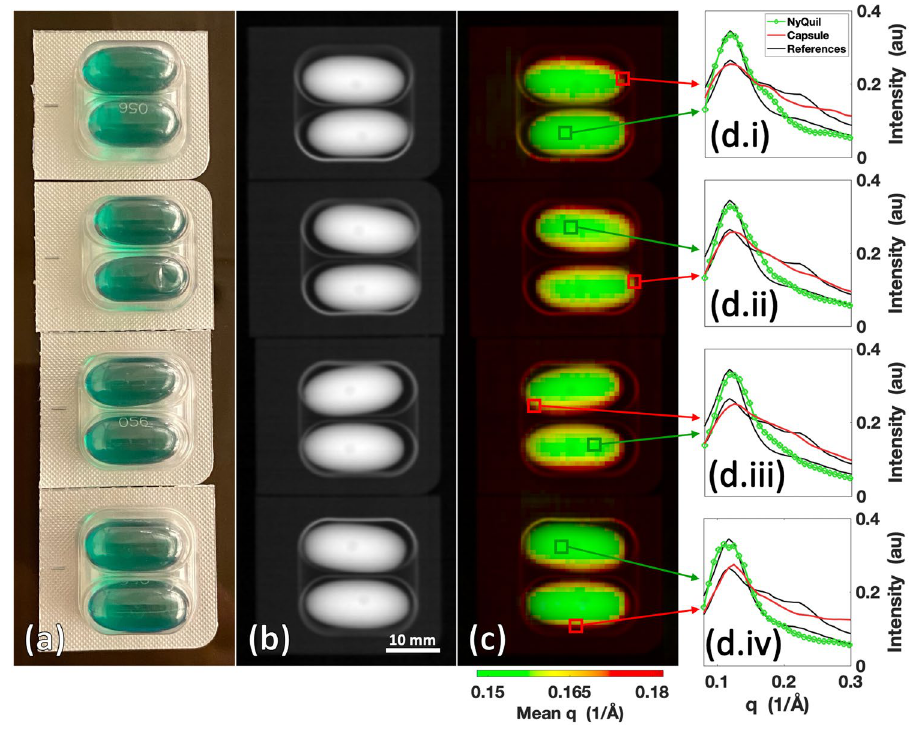
Figure 5. Packaged NyQuil pills scanned by the X-ray fan beam coded aperture imaging system. ( a ) Photograph of the packaged NyQuil pills. ( b ) Transmission scan of packaged NyQuil pills. ( c ) Combined transmission + mean q colorization (TQC) image of NyQuil pills. ( d.i – iv ) XRD spectra from each package for individual voxels predominantly containing liquid NyQuil and soft gel capsule compared against commercial diffractometer measurements of each